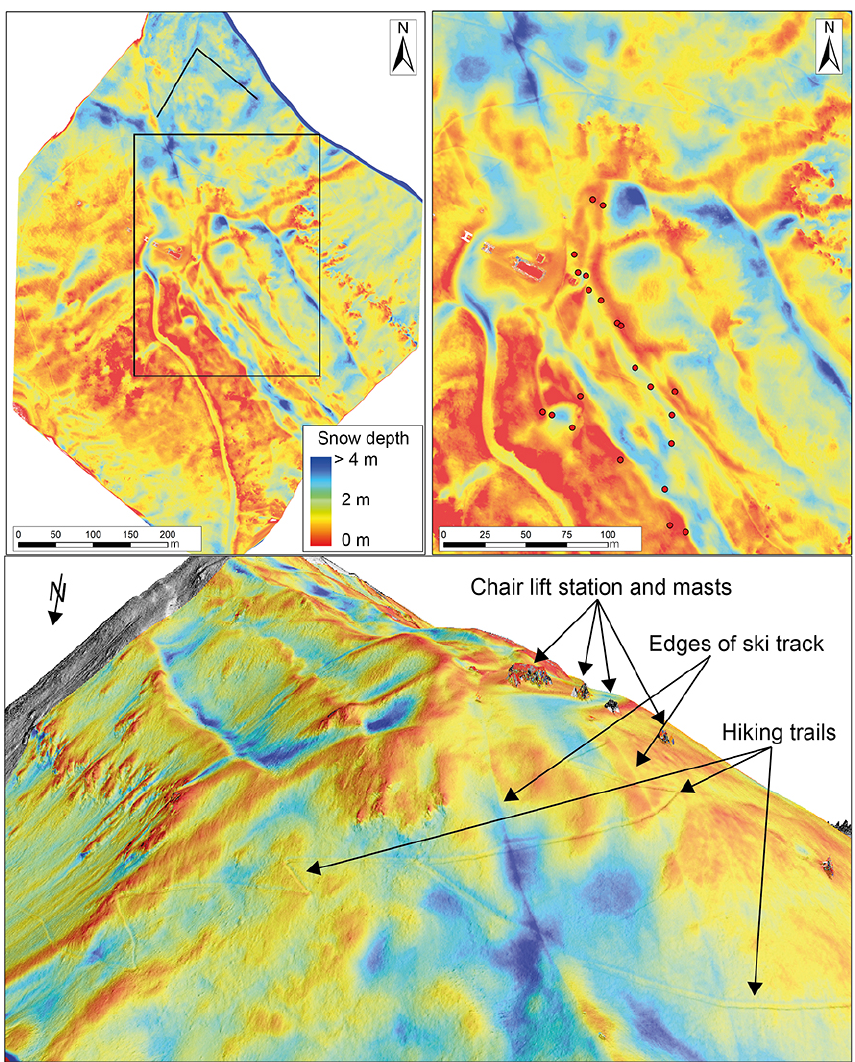
Figure 6. Overall HS map of the Brämabühl test site (top left panel) and close-up of the central part (top right panel). The locations of the reference plots are displayed as red circles. 3-D view of the HS draped over the hillshade of the snow-free DSM facing from north to south (bottom